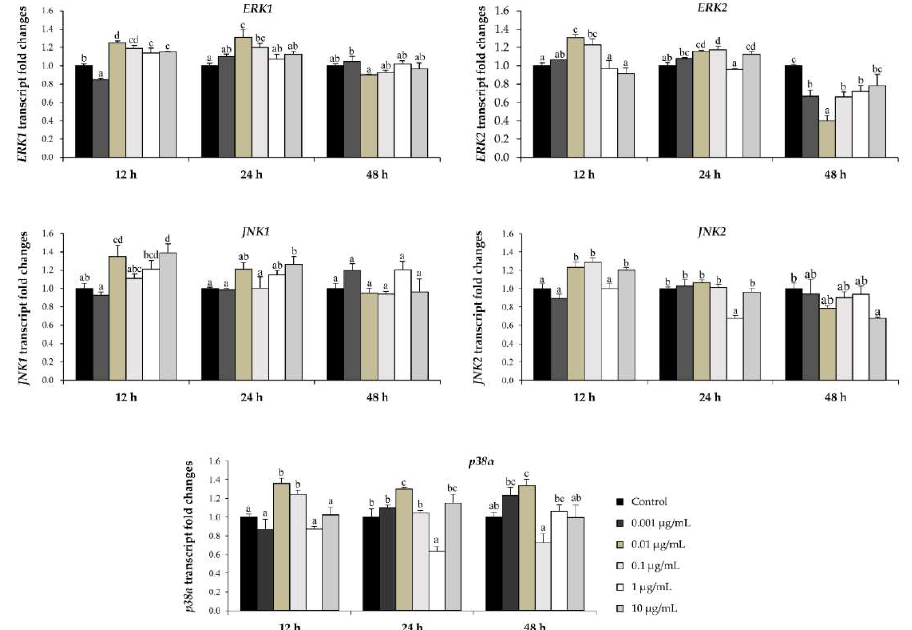
Figure 6. Quantitative real-time PCR was used to analyze the expression of MAPK pathway genes ERK1 , ERK2 , JNK1 , JNK2 , and p38 α in osteoblast cells cultured with various concentrations of L -quebrachitol for 24, 48 and 72 h. A representative example of 3 independent experiments. Each data point represents the means of 4 replicate samples ± SEM. The data in columns with different letters in each group were significantly different at p < 0.05.